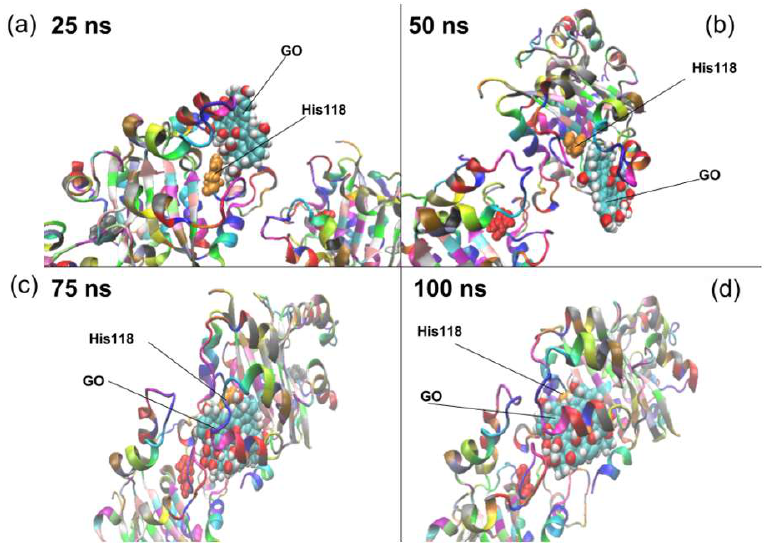
Figure 2. The position of the graphene oxide at ( a ) 25 ns; ( b ) 50 ns; ( c ) 75 ns and ( d ) 100 ns intervals are shown relative to the positions of the His118 residue and the NDPK enzyme. It can be seen that by 50 ns, graphene oxide starts interacting with the His118 residue and by 100 ns, graphene oxide completely blocks His118 residue’s interaction with the environment. NDPK is represented as a cartoon with a coloring style based on individual residues and His118 and graphene oxide are shown in the CPK representation showing the oxygen and hydrogen functionalities in red and white with carbon in cyan